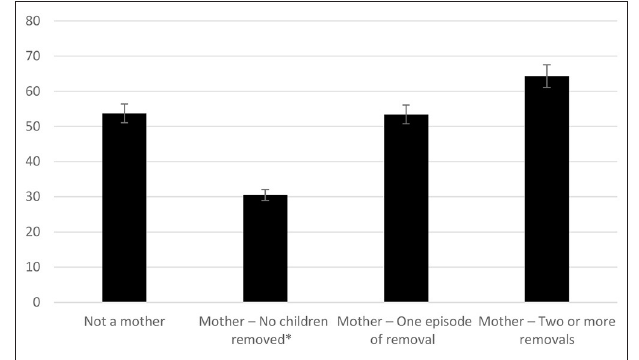
FIGURE 1 | Prevalence of suicide attempts (%) across different removal groups in mothers. *Indicates significant difference between groups ( p =